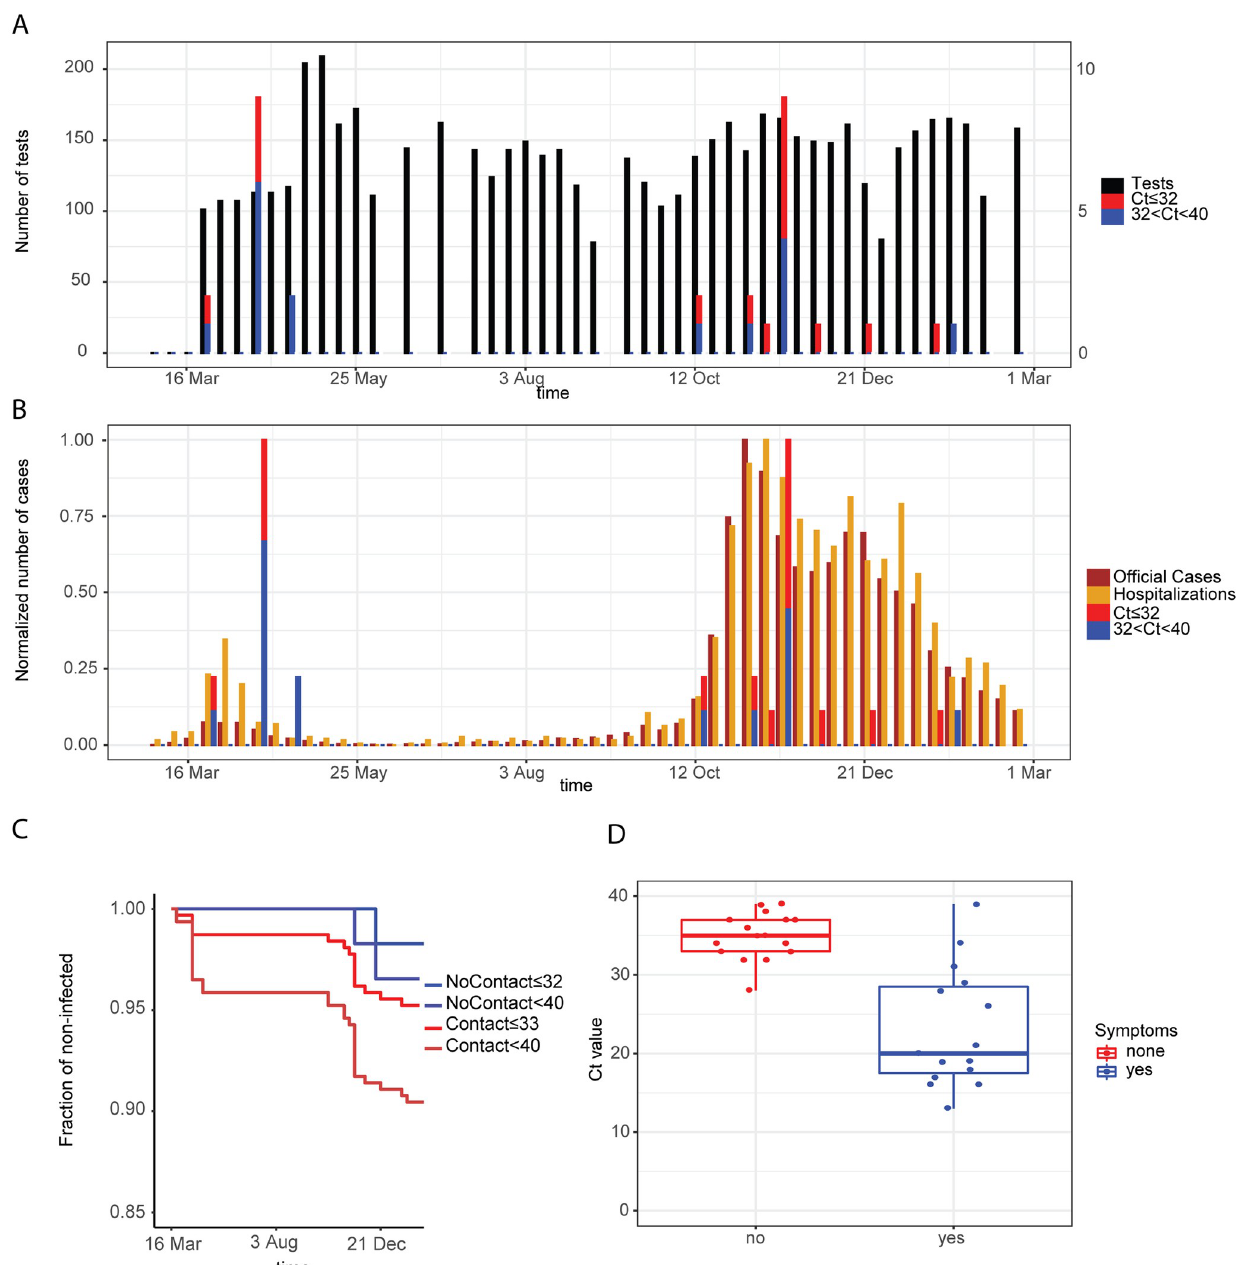
Fig 1. Results of the testing pipeline in asymptomatic healthcare workers. (A) Number of tests (left y-axis) and number of positive tests (right y-axis) for two different thresholds of the Ct value of the PCR test, 32 and 40, for the healthcare workers in contact with patients. (B) Number of the sum of the last 7 days of official positive cases, sum of the last 7 days of official hospitalized cases, and positive cases for the healthcare workers. (C) Kaplan-Meier curves of infected workers healthcare workers distinguishing healthcare workers and workers without contact with patients. (D) Boxplot showing the Ct value observed in the infected healthcare workers that reported having symptoms and the healthcare workers without symptoms.